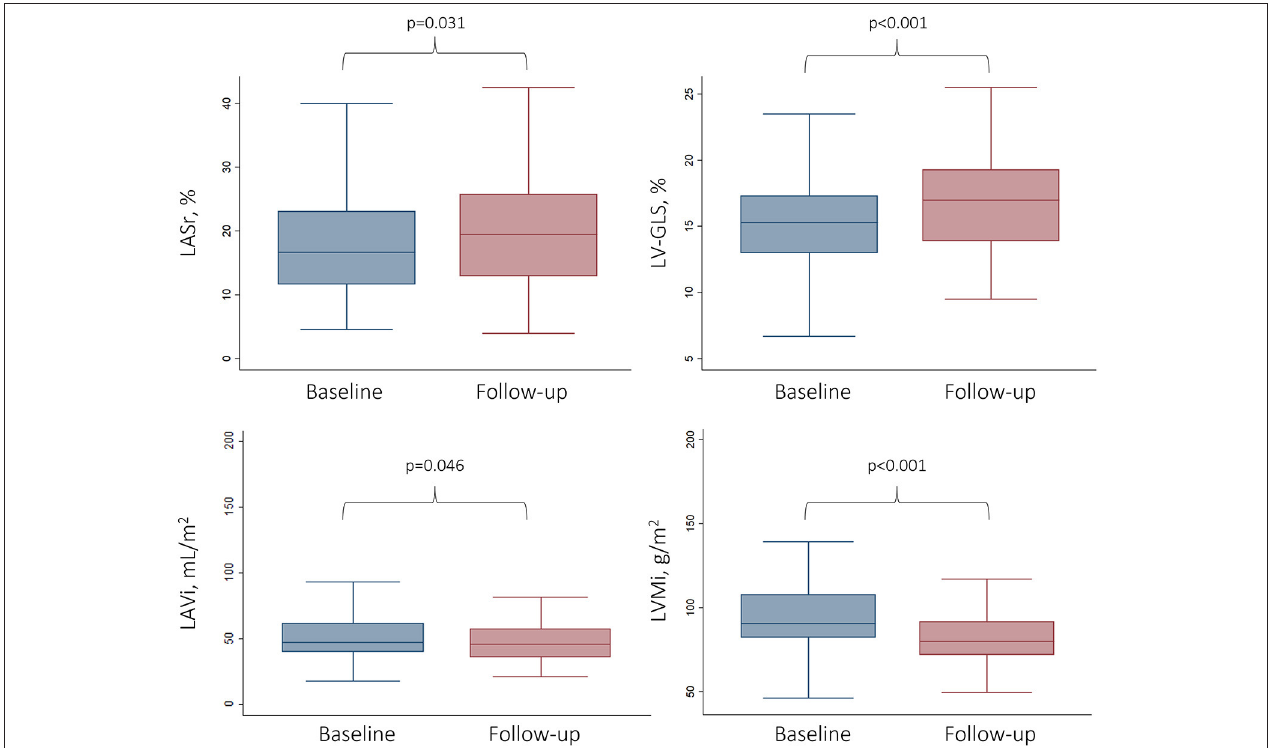
FIGURE 2 | Changes in functional and anatomical LA and LV parameters following TAVI. Box and whisker plots represent the baseline vs. the follow-up values (6 months after TAVI) for LA and LV parameters. LV-GLS, Left ventricular global longitudinal strain; LASr, Left atrial peak reservoir strain; LAVi, Left atrial volume index; LVMi, Left ventricular mass index.